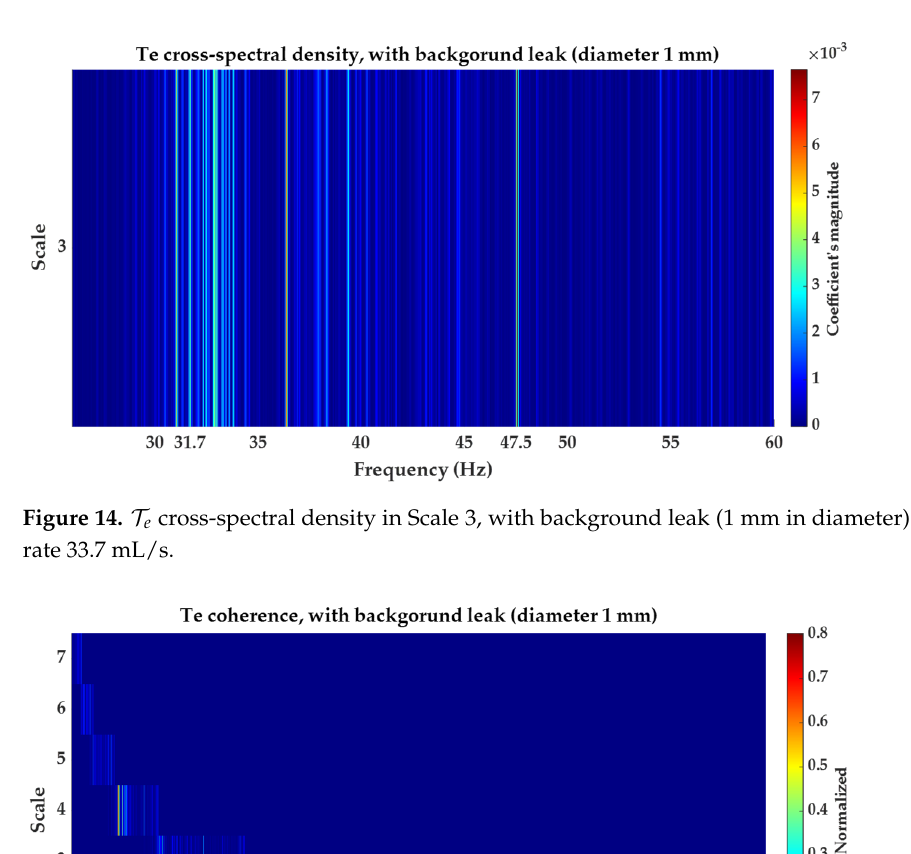
Figure 13. 𝒯 (cid:3032) cross-spectral density in Scale 4 , with background leak ( 1 mm in diameter) and flow rate 33.7 mL/s .